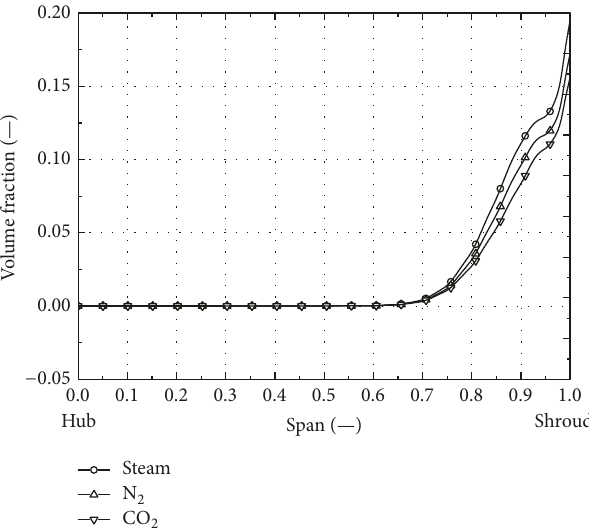
Figure 23: Volume fraction obtained from the meridional surface at the same radius of the injectors.